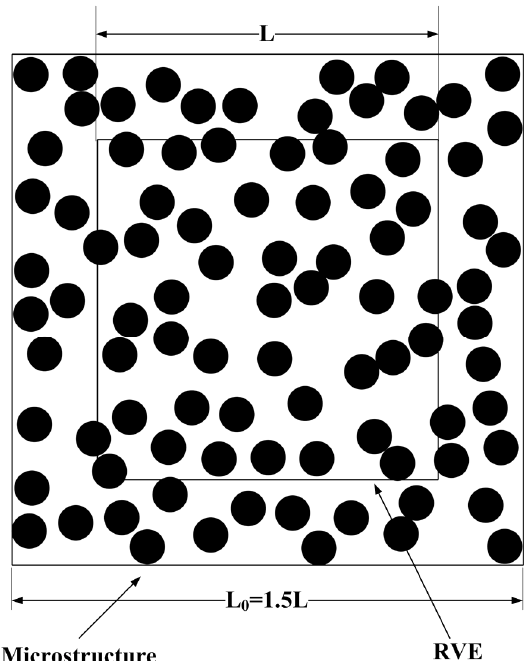
Figure 1. Depiction of RVE (representative volume element) for calculation of thermal conductivity.